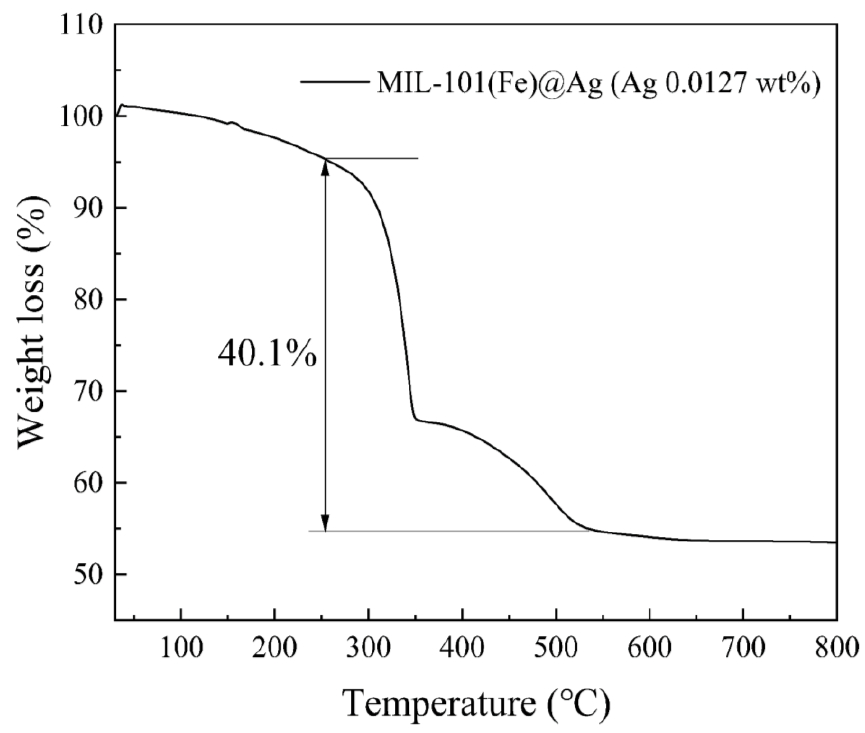
Figure 7. TG curve of MIL-101(Fe)@Ag (Ag 0.0127 wt%).